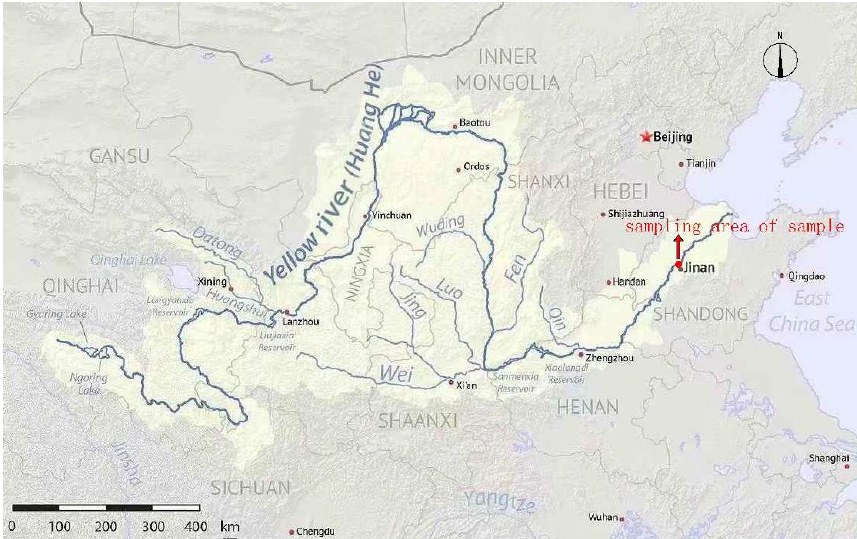
Figure 1. The map of the sampling area. Table 1. The physical parameters of the soil samples. Natural Moisture Yellow River Silt